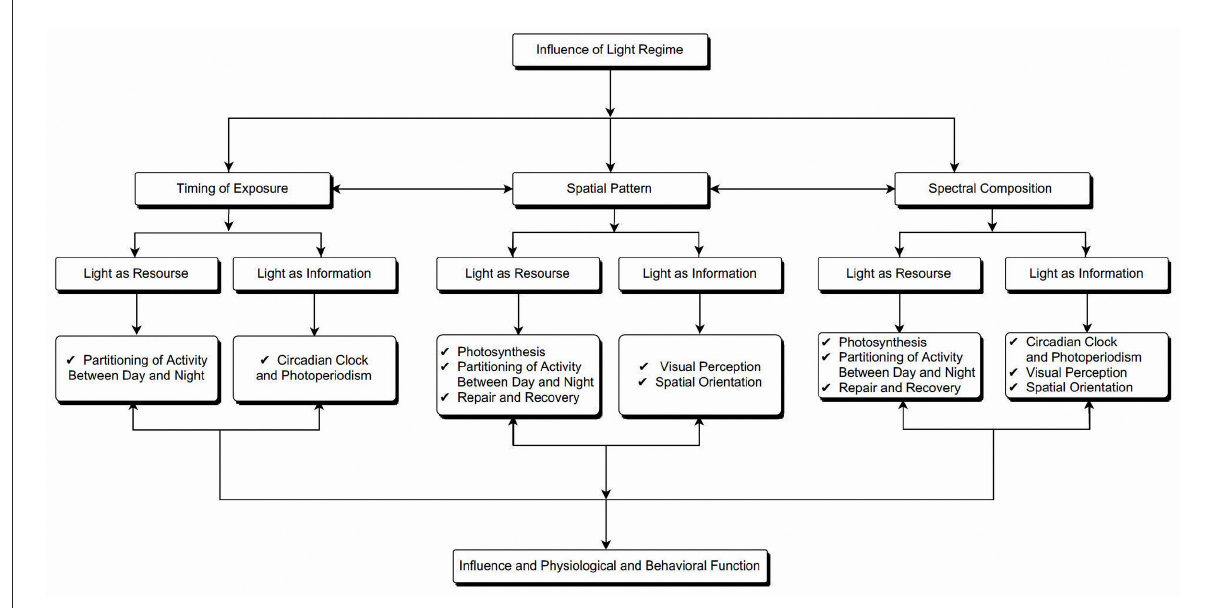
FIGURE1 Schematic representation of the influence of light as both resource and source of information in organisms and how it influences their physiological and behavioral